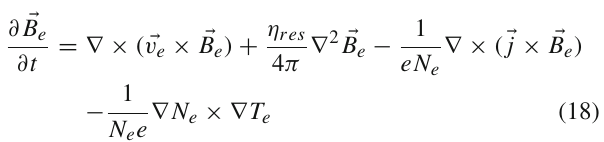
why the density gradient and the temperature gradient would be misaligned due to the neutrino currents in the shocks of the cosmic